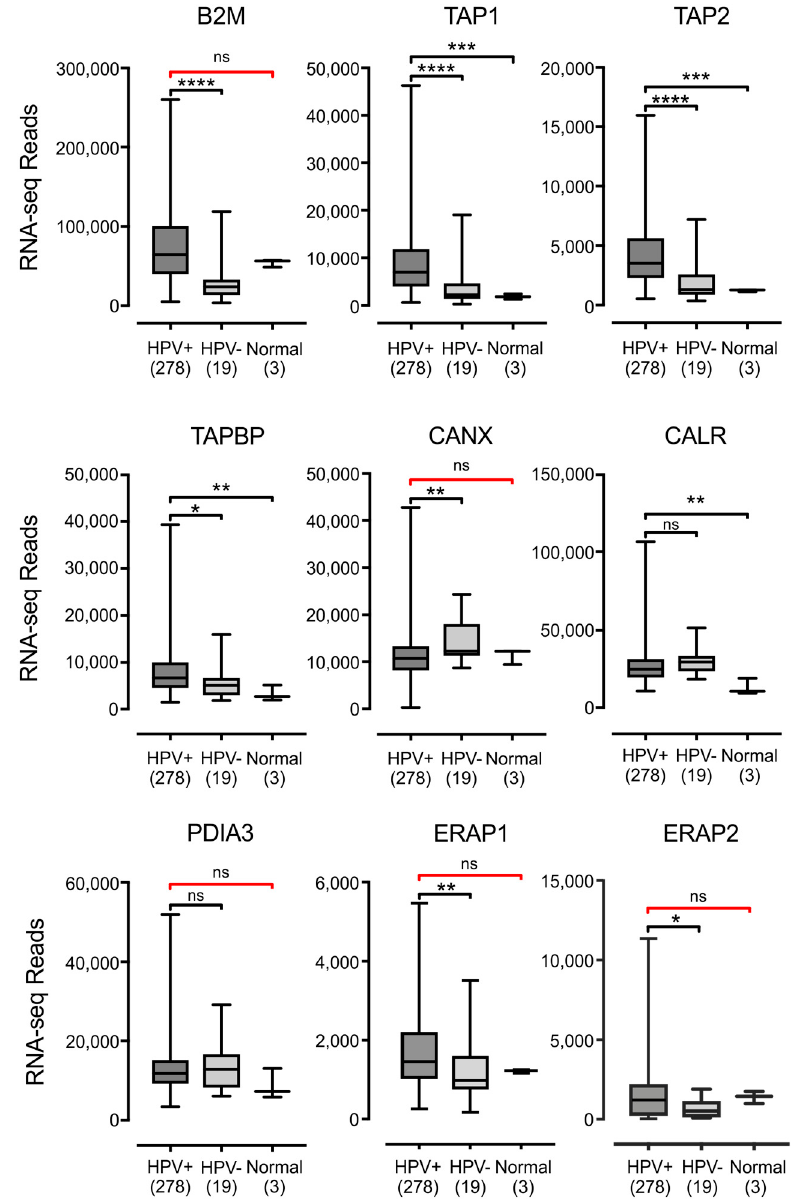
Figure 4. Expression of the MHC-I light chain and other genes involved in MHC-I dependent antigen presentation in cervical carcinomas stratified by HPV status. Normalized RNA-seq data for the indicated genes involved in MHC-I dependent antigen presentation was extracted from the TCGA database for the CESC cohort for HPV+, HPV − , and normal control tissues. Numbers in brackets refer to the number of samples included in each analysis. * p ≤ 0.05; ** p ≤ 0.01; *** p ≤ 0.001; **** p ≤ 0.0001; ns—not significant; red brackets indicate a comparison that did not achieve significance with a power value <0.8.